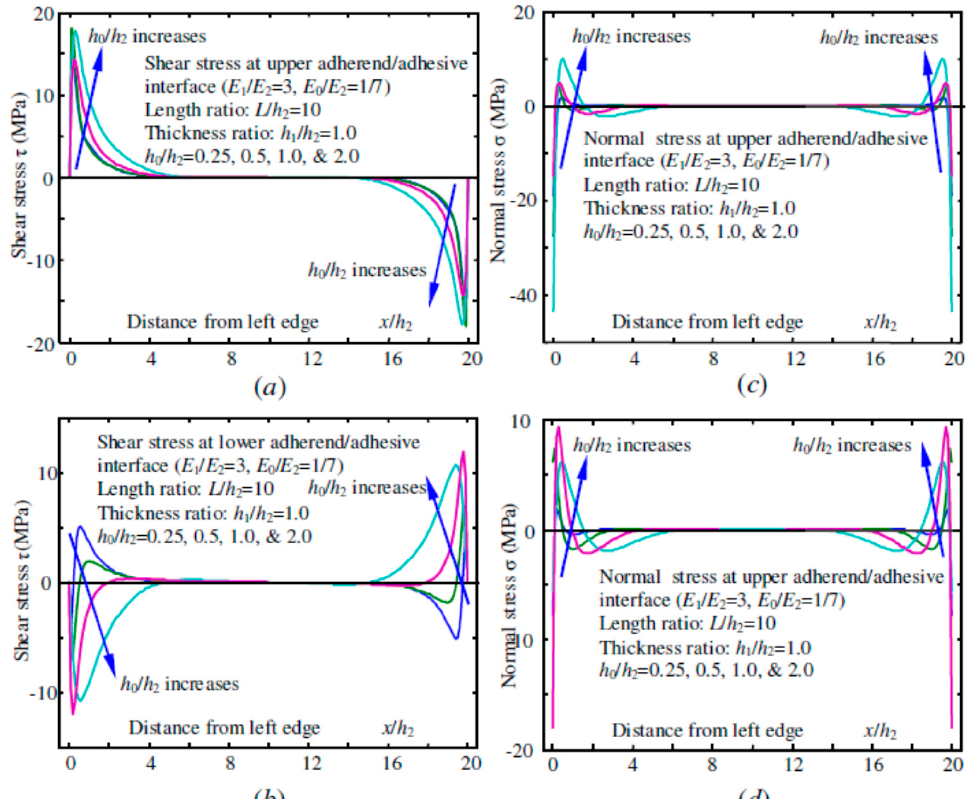
Figure 9. Comparison of thermomechanical interfacial shear and normal stresses at the upper and bottom surface of the adhesive layer of an ASSJ subjected to uniform temperature change ( ∆ T = 120 ◦ C; E 1 / E 2 = 1/3; E 0 / E 2 = 1/7; L / h 2 = 20; h 1 / h 2 = 1.0; and h 0 / h 2 = 0.1, 0.25, 0.5, and 1.0, respectively). ( a , b ): Shear stresses at the upper and lower adherend/adhesive layer interfaces, respectively; ( c , d ): Normal (peeling) stresses at the upper and lower adherend/adhesive layer interfaces, respectively.